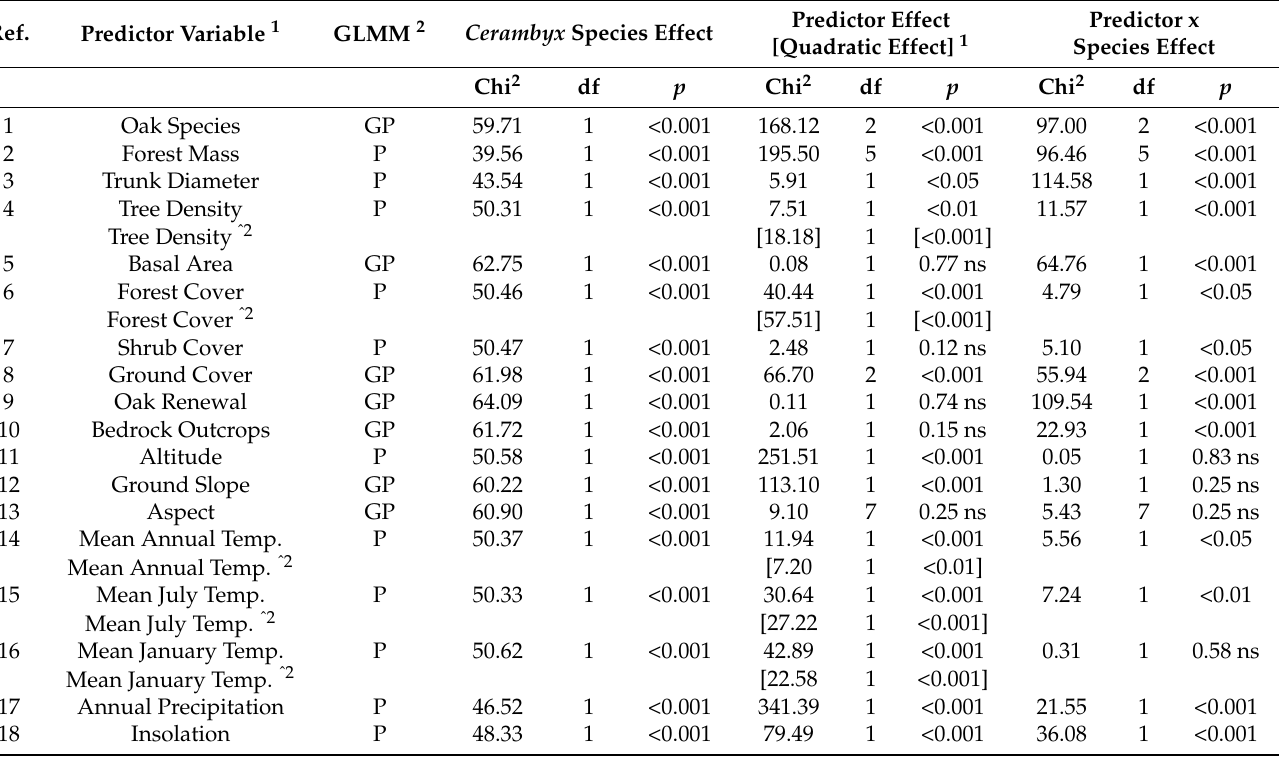
Table 2. Analysis of deviance table (Type II Wald Chi-square tests) from GLMMs showing the effect on the abundance for each Cerambyx species ( C. cerdo and C. welensii ) of the 18 predictor variables and the predictor x species